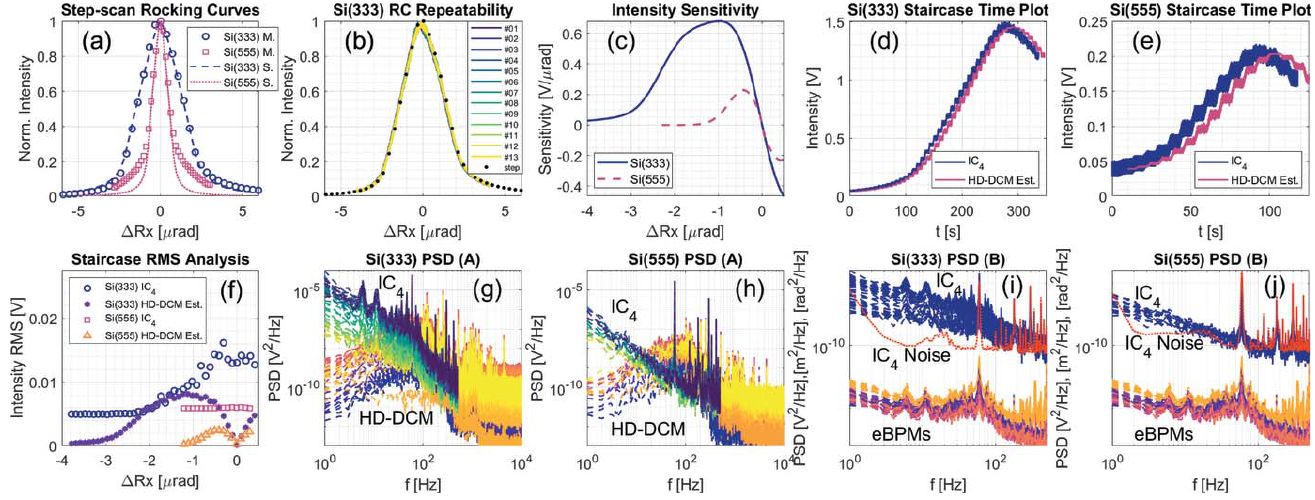
Figure 9 Rocking-curve-based stability assessment with the HD-DCM: ( a ) Si(333) and Si(555) rocking-curve measurements (M) via step-scans compared with simulations (S); ( b ) fly-scan rocking-curve repeatability test, with 13 measurements over about 2.5 h; ( c ) intensity sensitivity curves based on the derivative of the Si(333) and Si(555) rocking curves; ( d and e ) intensity staircase time plots of ionization chamber IC 4 for Si(333) and Si(555), together with intensity variation estimates from the HD-DCM internal metrology (with a time offset of 10 s for readability); ( f ) root-mean-square (RMS) values from the steps of the staircase measurements and estimates; ( g and h ) power spectral density (PSD) from the steps of the staircase measurements and estimates; ( i and j ) PSD from staircase measurements together with electron beam position monitor (eBPM) data and IC 4 noise floors [note: eBPM data in ( i ) borrowed from ( j ) measurements due to data loss, but without any loss of applicability]. For further details see